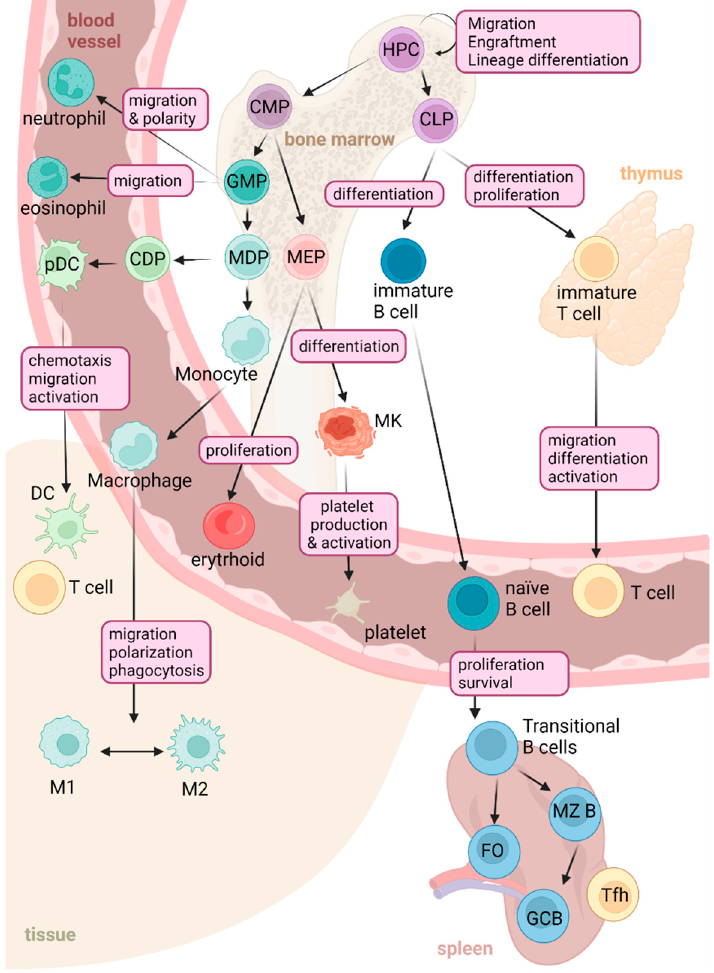
Figure 1. Functions of RhoA signaling in the immune system.